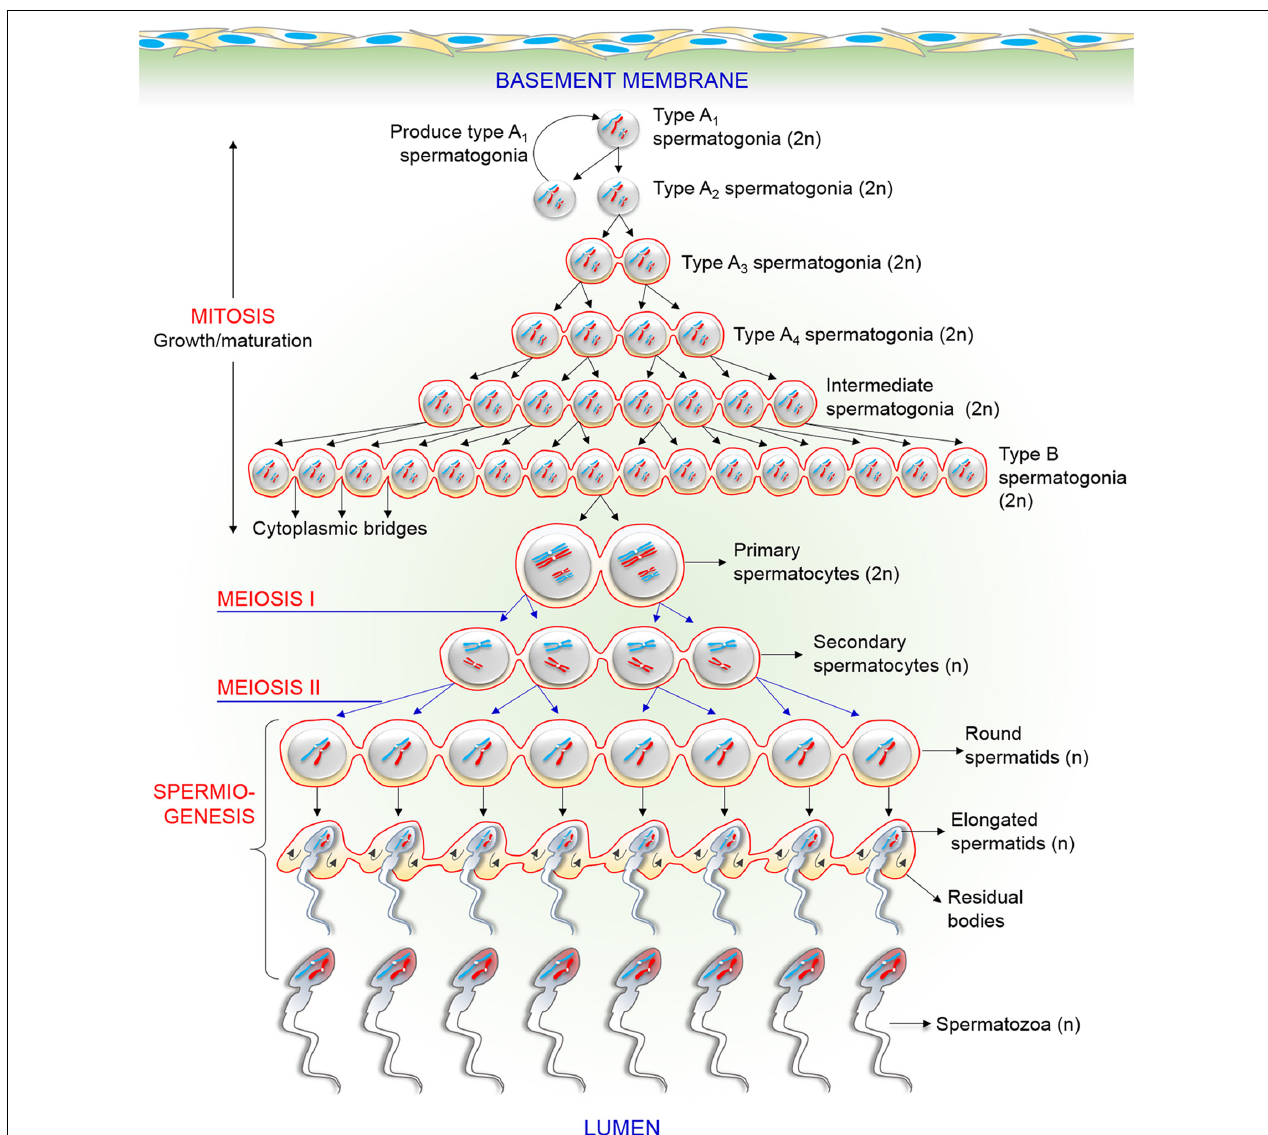
FIGURE 1 | Schematic drawing of the process of various events in male germ cells during spermatogenesis and spermiogenesis. The figure particularly displays the existence of intercellular bridges among spermatogenic cells. Each generation of cells is connected by intercellular bridges, thus, it divides synchronously in cohorts. See the main text for a detailed